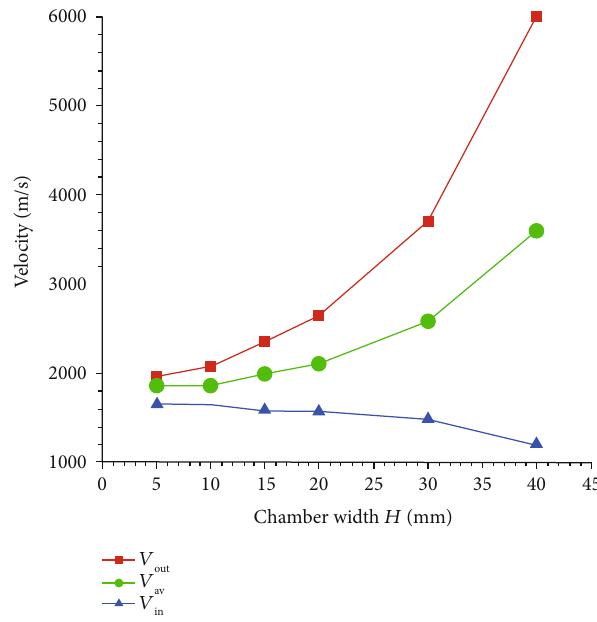
Figure 15: Propagation velocity distribution with di ff erent chamber widths.